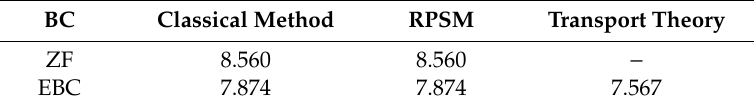
Table 7. The slab reactor critical radius for two boundary